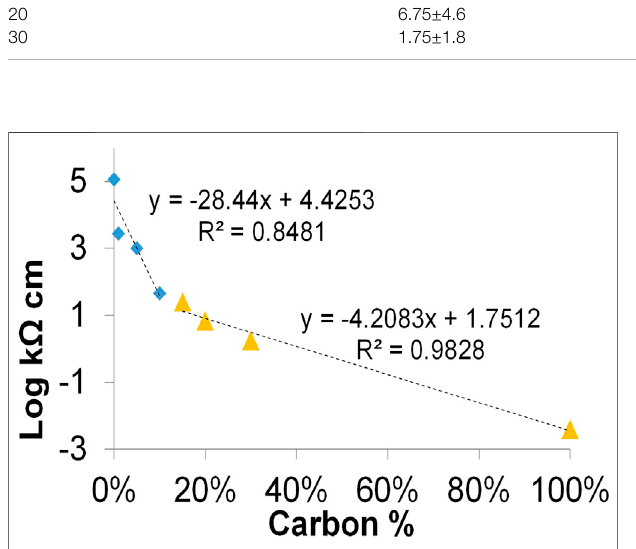
FIGURE 5 | Graphic of the average of the electrical resistivity for composite A measured at different carbon %. The linear equation and regression coef fi cient (R 2 ) for values in the range 0 – 10 % (blue rhomboid points) and 15 – 100 % (orange triangles) are